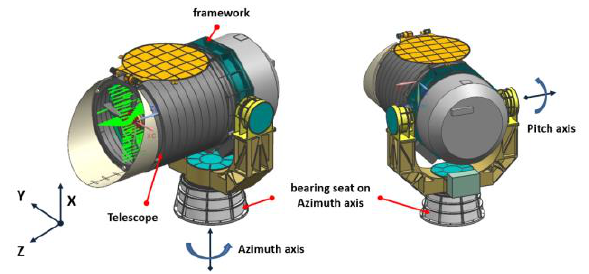
Figure 12 Two-Dimension Rotate Platform Scheme The structural modal frequencies of the optical axis 0° and the optical axis 65° are calculated separately. The first two frequencies of the whole machine are shown in Table 3. The fundamental frequency of the whole machine is 22.7 Hz in both the optical axis 0 ° and the optical axis 65°. The first two modes